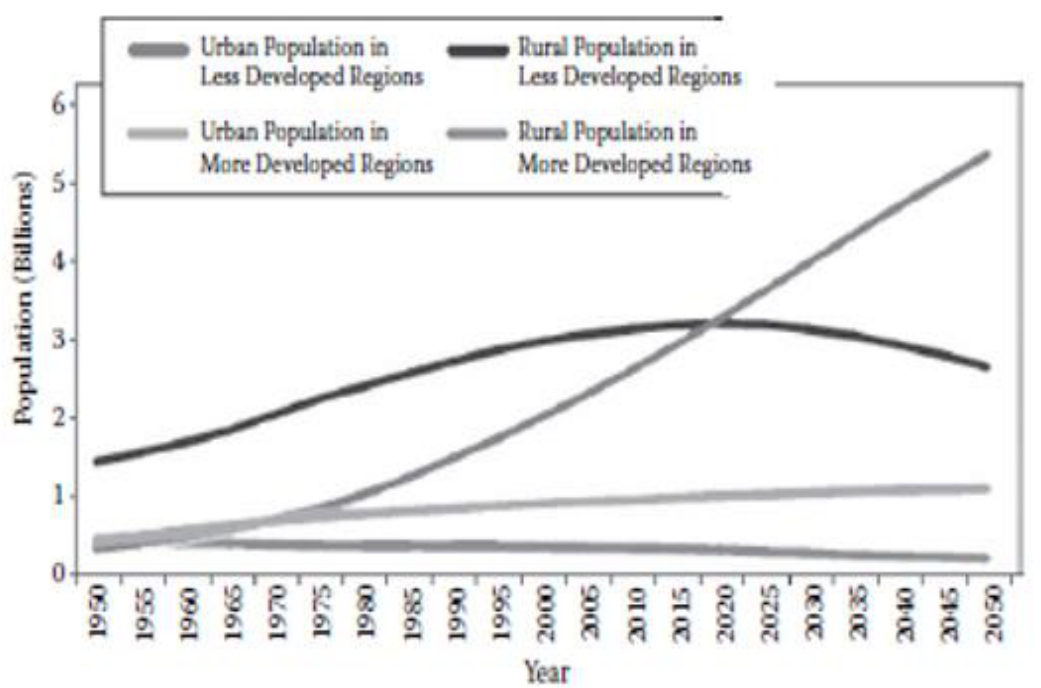
Figure 3. Urban and rural populace growing of the sphere